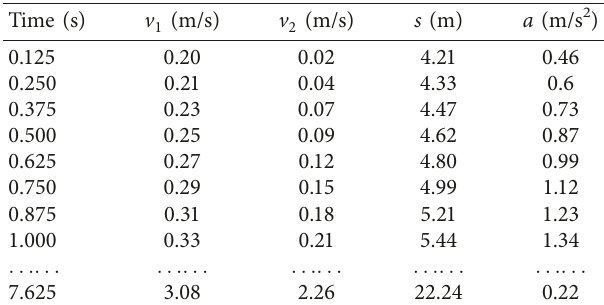
Figure 2: Setting of field video